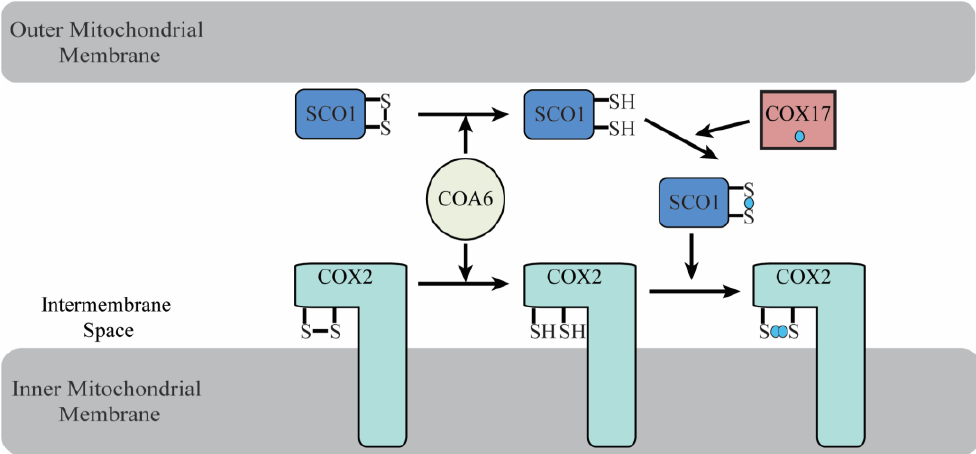
Figure 4. A schematic diagram of the biochemical role of COA6 in the metallation of COX2. The metallation of SCO1 and COX2 requires that their copper-binding cysteines are in the reduced form. COA6 acts as a disulfide reductase in this process, reducing the cysteines of both oxidized SCO1 and COX2, enabling their copper metallation by Cu-COX17 and Cu-SCO1, respectively.